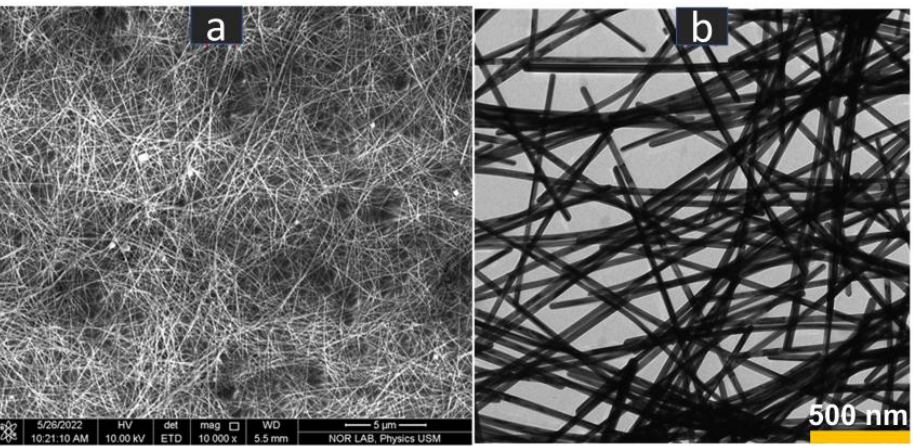
Figure 3. Electron micrograph showing ( a ) FESEM and ( b ) TEM images of AgNWs prepared using the modified polyol technique.